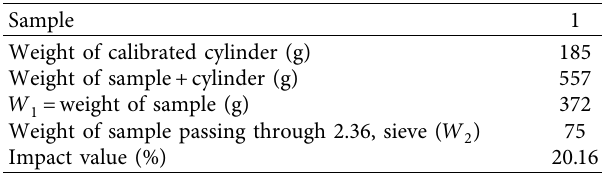
Table 5: Aggregate impact test value.